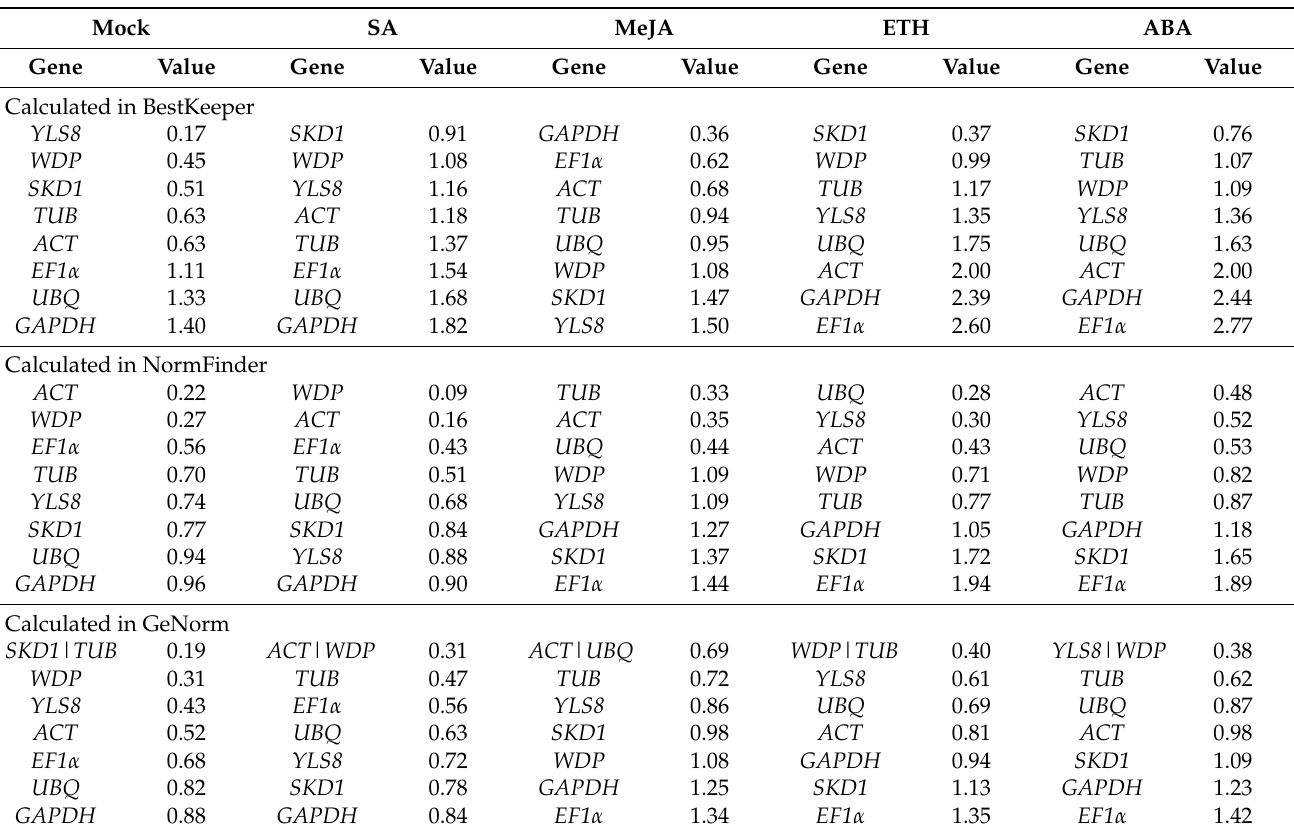
Table 2. Ranking of the expression stability of the eight candidate reference genes in pears un- der control conditions and hormone treatments with Cq values being calculated using statistical algorithm